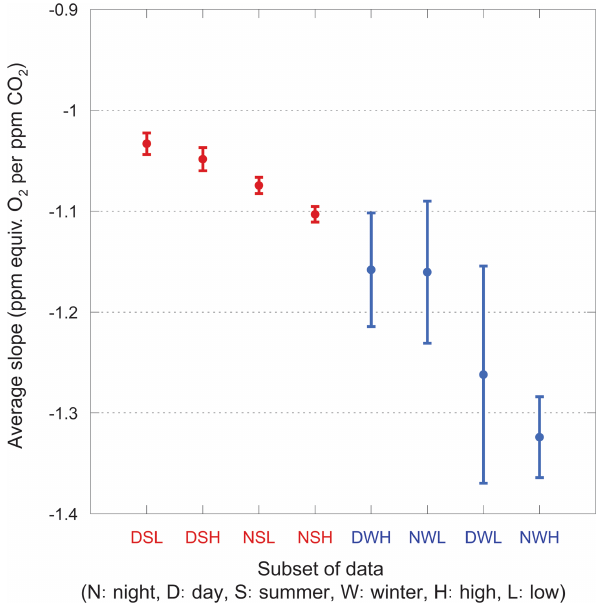
Figure 9. Average slopes for various nonoverlapping subsets of the data. Error bars show the standard error on the mean. Winter data are shown in blue, summer in red. Categories are ordered by in- creasingly negative mean values for